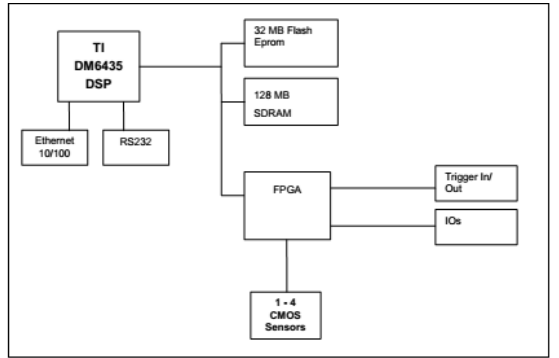
Figure 3. Electronic system diagram of the prototype